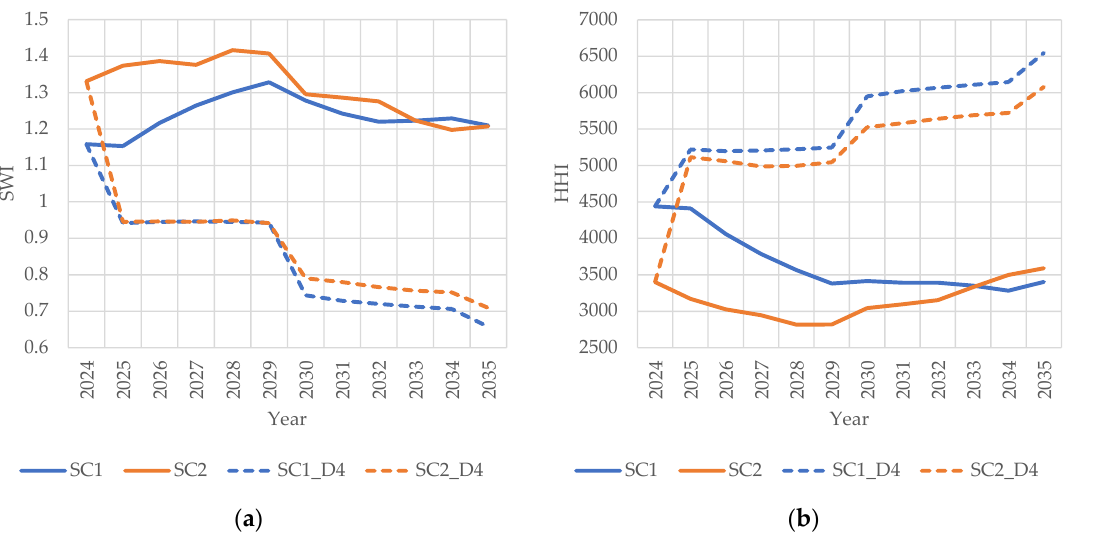
Figure 12. Diversity indicators in the case of the loss of wind generators: ( a ) SWI; ( b ) HHI.